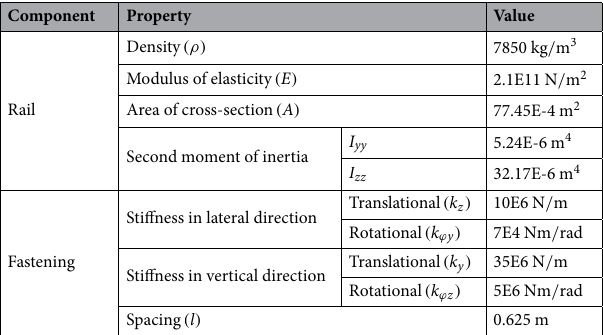
Table 1. Properties of the rail track fastening system 50 .